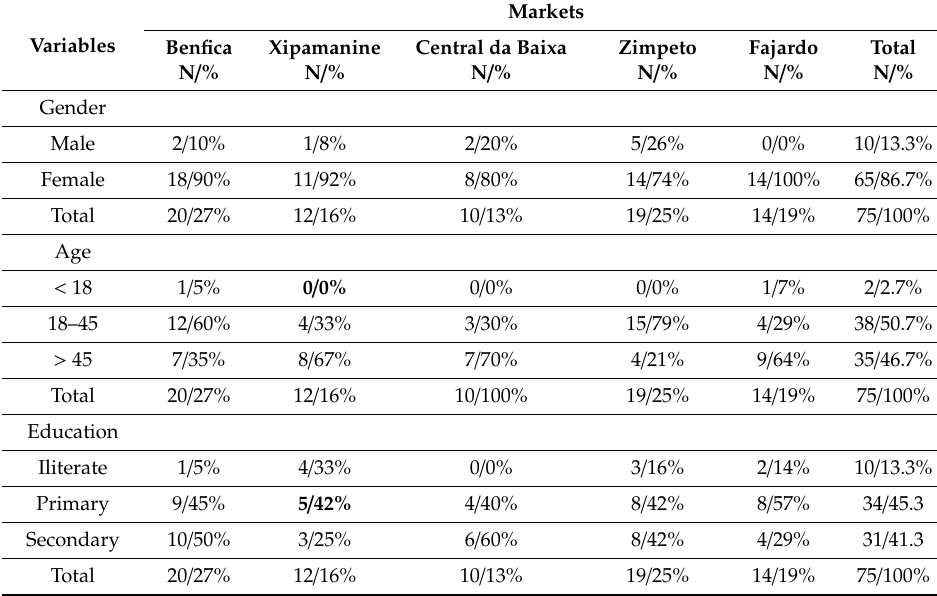
Table 1. Profile of the vendors of the five markets